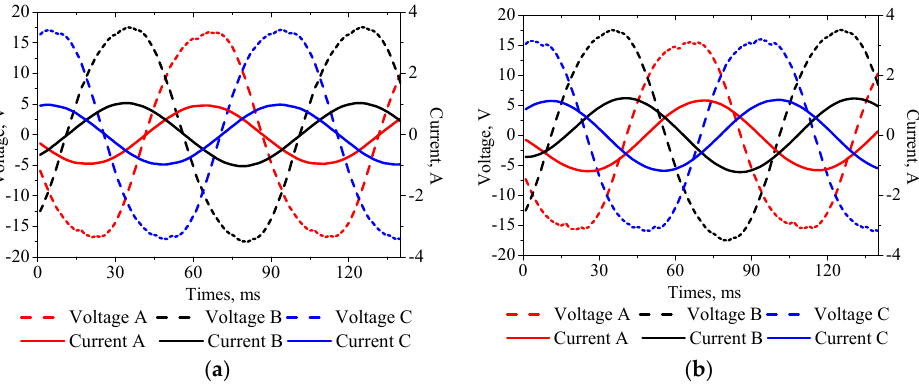
Figure 7. The voltage and current waveforms of MI-TLPMG on the resistance and resistance–inductance load condition: ( a ) R = 18 Ω , ( b ) R = 12 Ω , L = 100 mH.